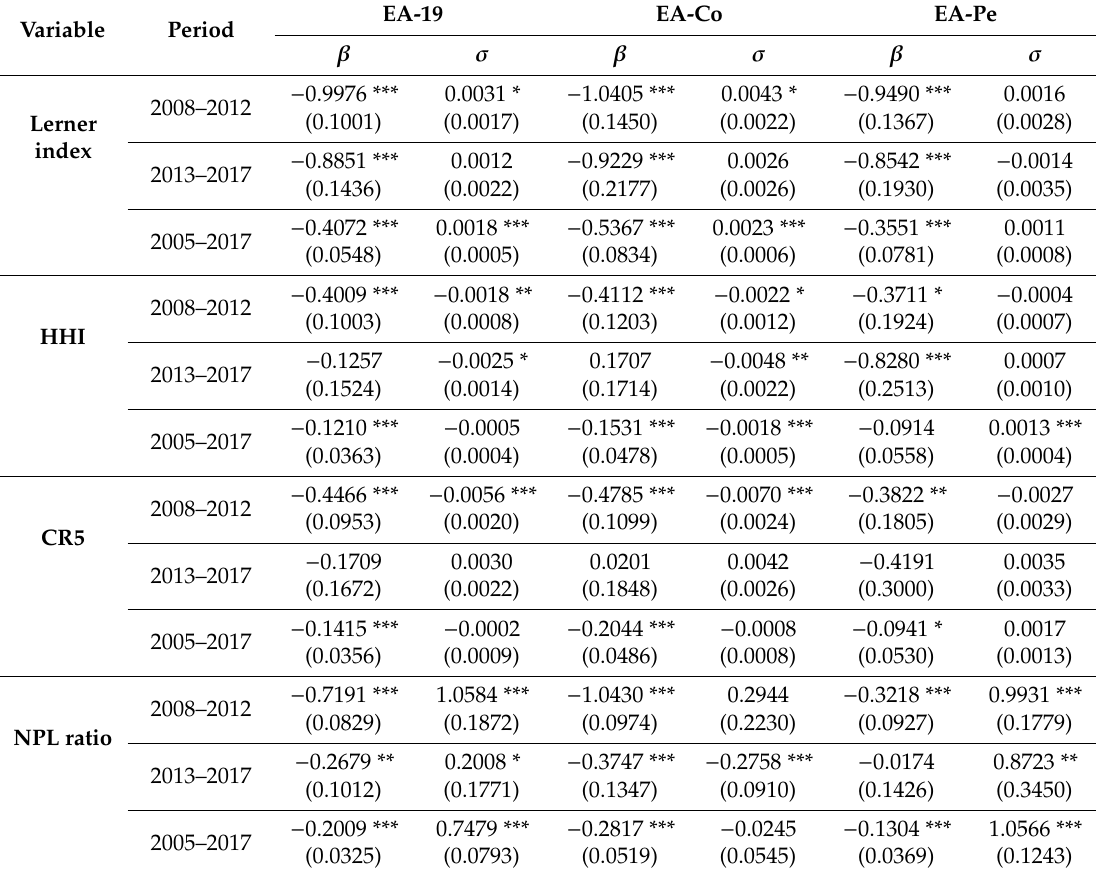
Table 7. Regression results for β -convergence and σ